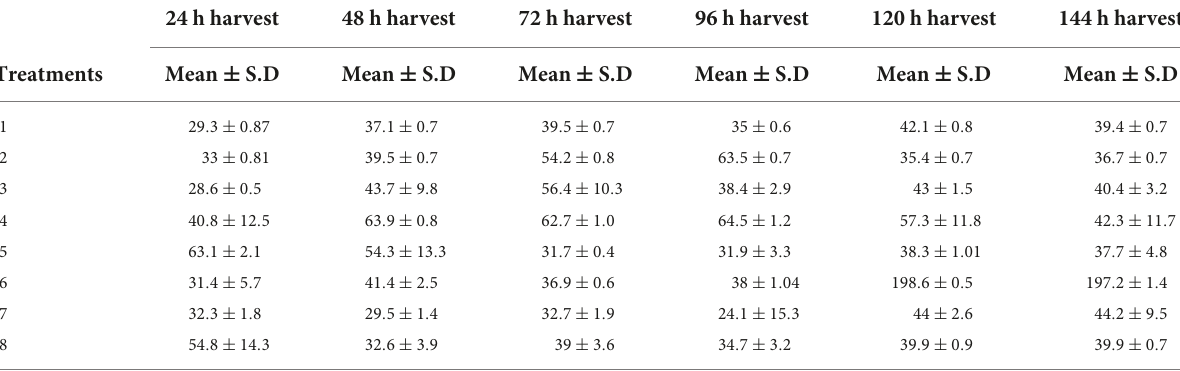
TABLE 8 NO levels (nmole g − 1 ) of Silybum marianum exposed to different treatments of elicitors.